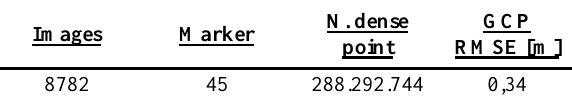
Table 2. Characteristics of the obtained point cloud of Via Sant’